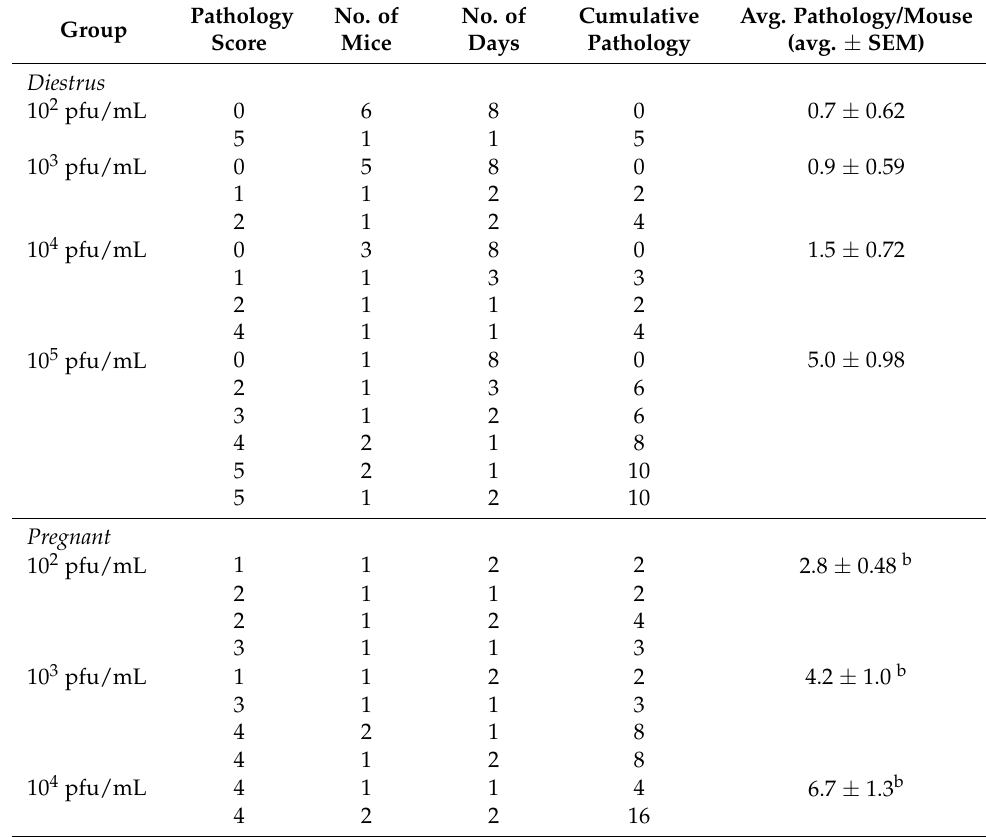
Table 1. Cumulative pathology scores for nonpregnant, diestrus-staged and pregnant mice a .